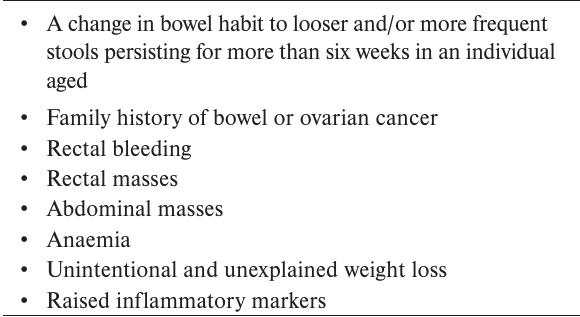
Table 3. Alarm symptoms that suggest organic intestinal disease 11 .